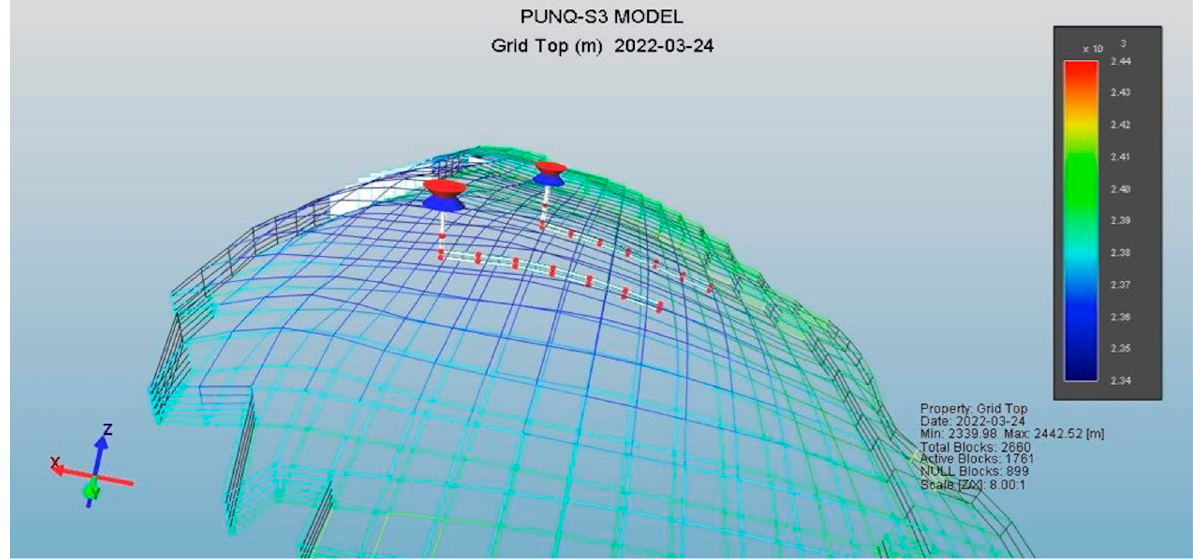
Figure 5. PUNQ-S3 reservoir grid positions of gas-injection, oil- and water-production completions.